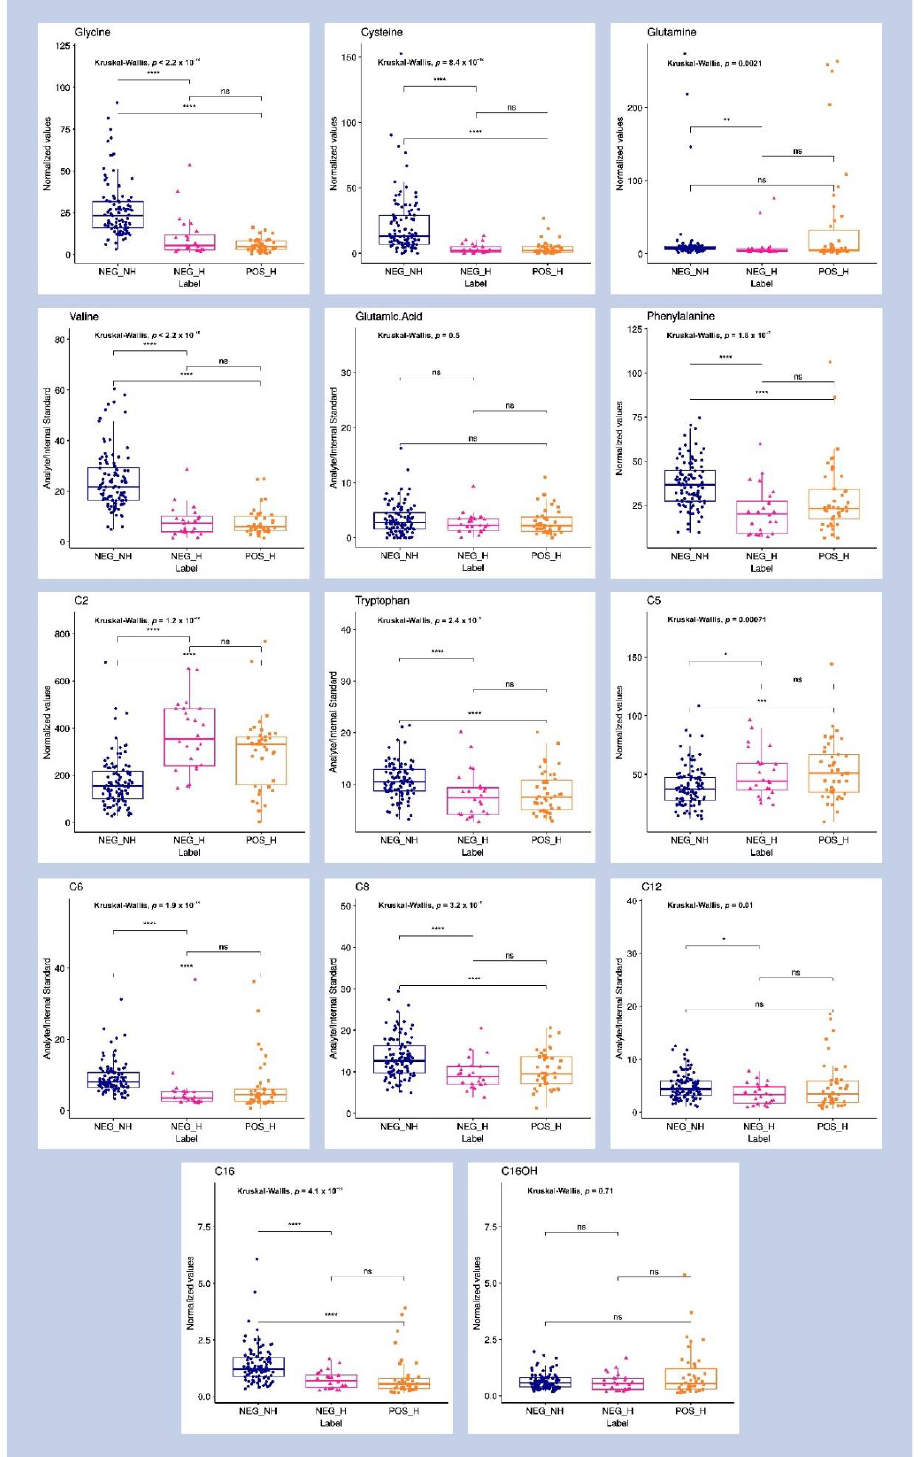
Figure 3. Box plots for the analytes found as discriminatory by the Lasso model and their abundance between the three classes of volunteers: healthy non-hospitalized COVID-19 PCR-negative (Neg-NH) volunteers, hospitalized COVID-19 PCR-positive (Pos-H) patients and suspected hospital- ized/symptomatic COVID-19 PCR-negative (Neg-H) patients. Univariate analysis was performed using the Kruskal–Wallis test. If a p -value is less than 0.05, it is flagged with one star (*). If a p -value is less than 0.01, it is flagged with 2 stars (**). If a p -value is less than 0.001, it is flagged with three stars (***). If a p -value is less than 0.0001, it is flagged with four stars